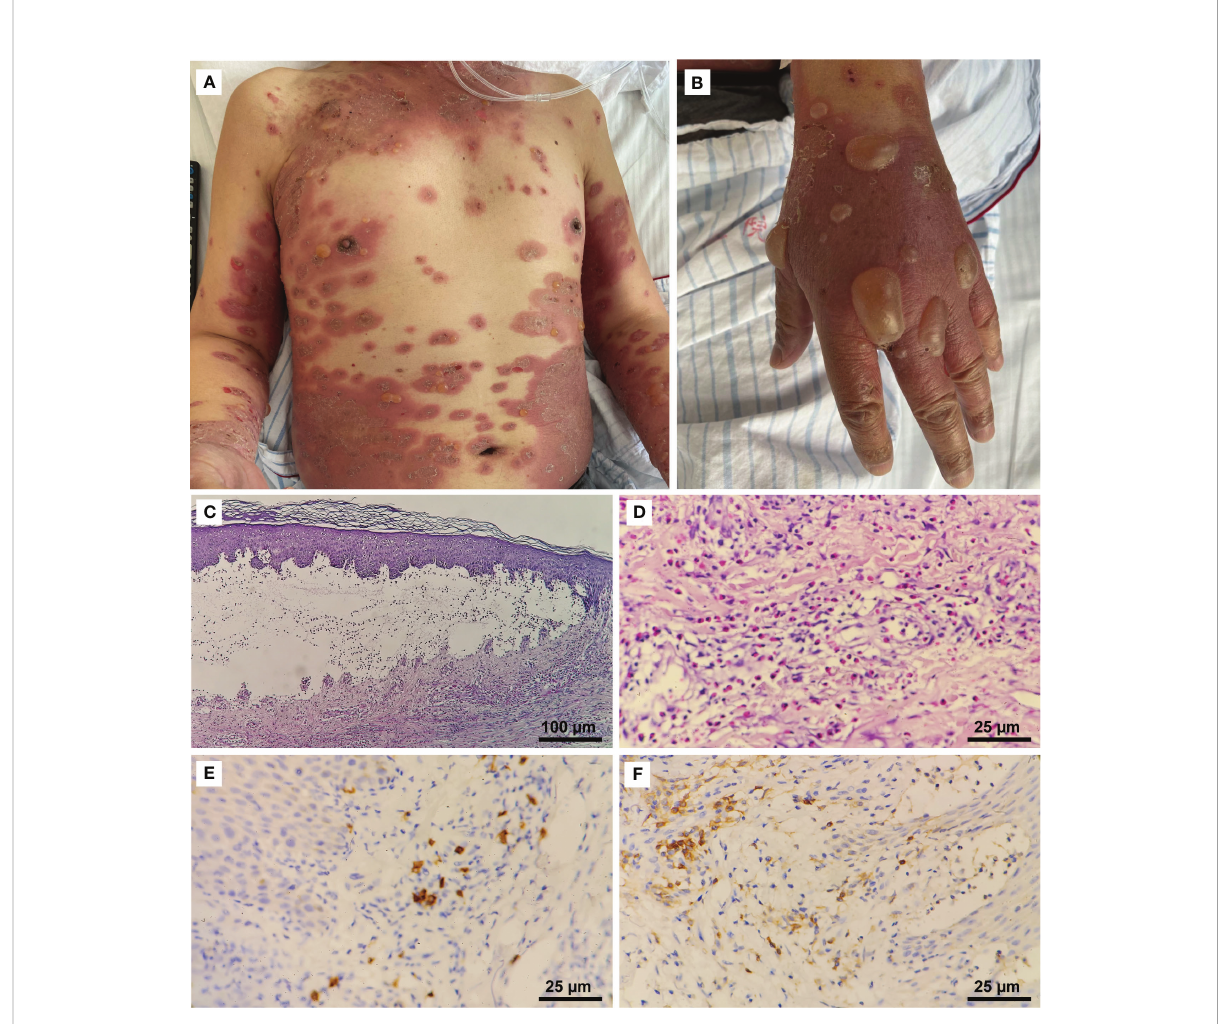
FIGURE 1 Clinical manifestations and histopathological features. (A) Erythematous patches and tense bullae on the patient ’ s trunk and extremities (CTCAE grade 3). (B) Numerous large tense bullae on the hand. (C) Histopathologic examination of a skin lesion on the right hand revealed a subepidermal blister cavity (H&E, 100×). (D) Eosinophils in fi ltrated the upper and mid-dermis (400×). Immunostaining revealed (E) a predominantly CD4 + (400×) lymphocytic in fi ltrate, with (F) a few CD8 + cells (400×) and the occasional CD20 +